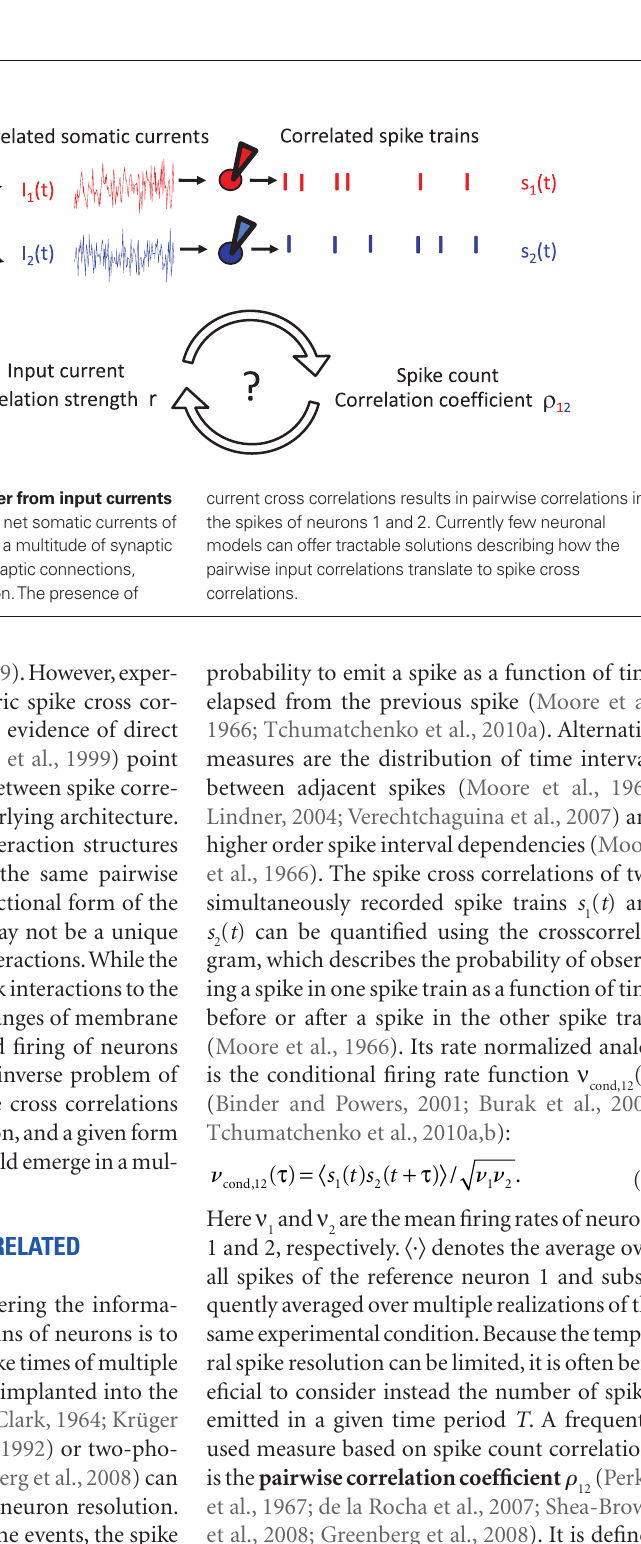
current cross correlations results in pairwise correlations in the spikes of neurons 1 and 2. Currently few neuronal models can offer tractable solutions describing how the pairwise input correlations translate to spike cross